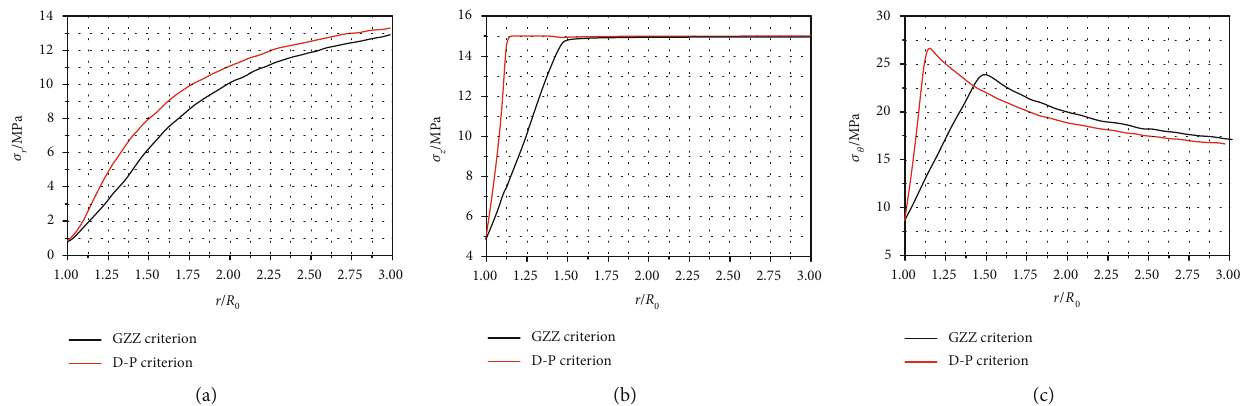
Figure 10: Stress distributions of surrounding rock under di ff erent strength criteria ((a) radial stress; (b) axial stress; (c) tangential stress).